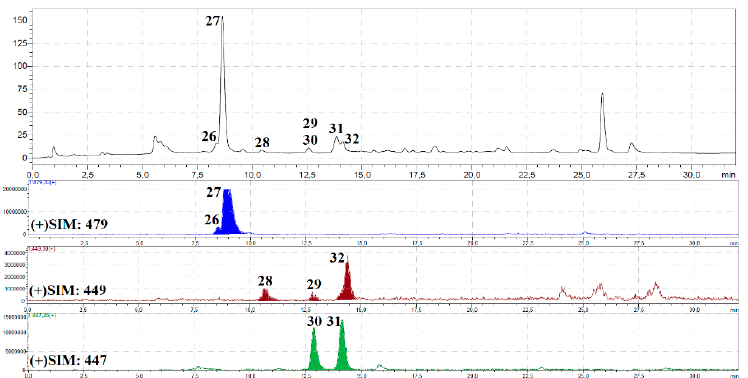
Figure 3. HPLC-DAD chromatogram (330 nm; ( a ) and some HPLC-ESI-MS chromatograms (SIM mode, positive ionization; ( b ) of methanol fraction of P. sibiricus roots. Compounds are numbered as listed in Table 2.